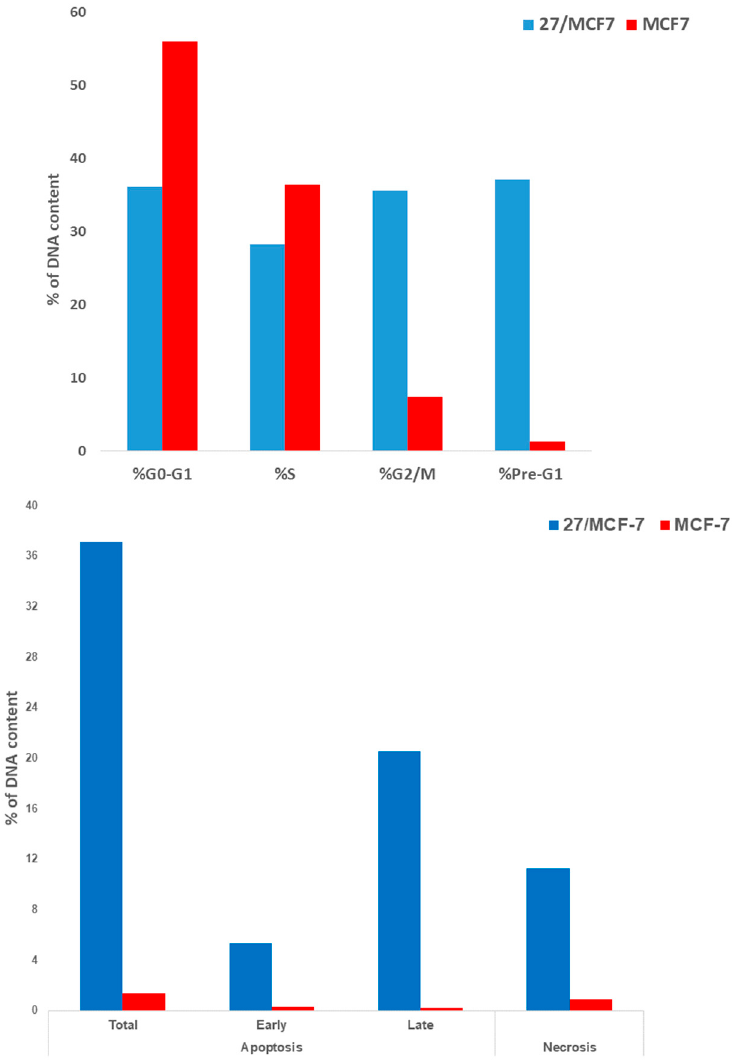
Figure 2. ( Up ),percent of DNA content in compound 27 -treated cells versus the control at different cell cycle phases. ( Down )percent of apoptotic cells in compound 27 -treated cells versus control (total, early, late, and necrosis).